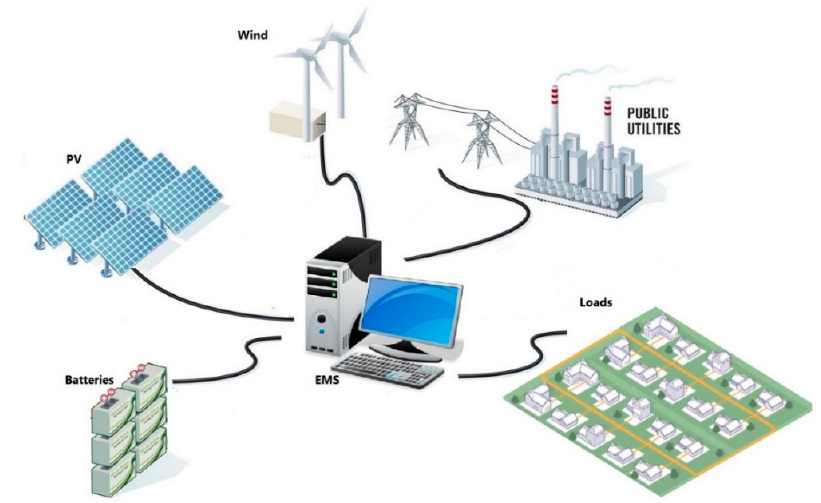
Figure 1. Basic structure of the proposed microgrid (MG).